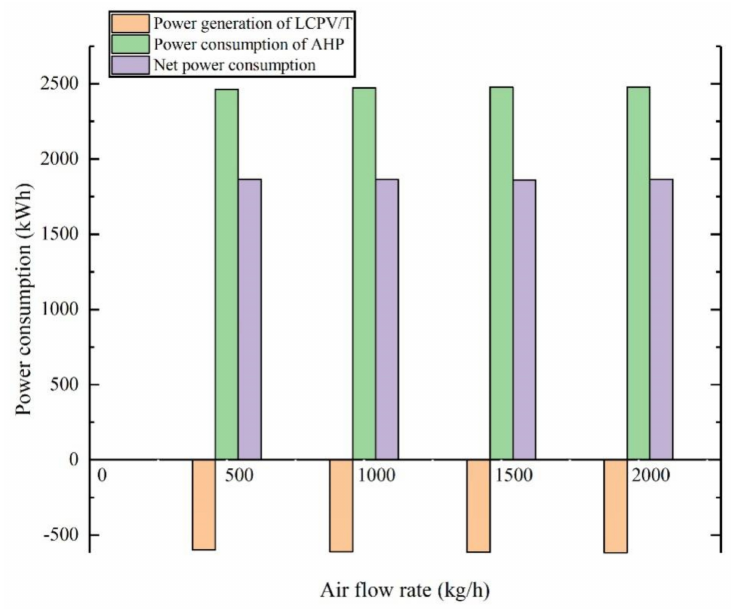
Figure 23. Power consumption of the AHP and the power production of the LCPV/T under variable air flow